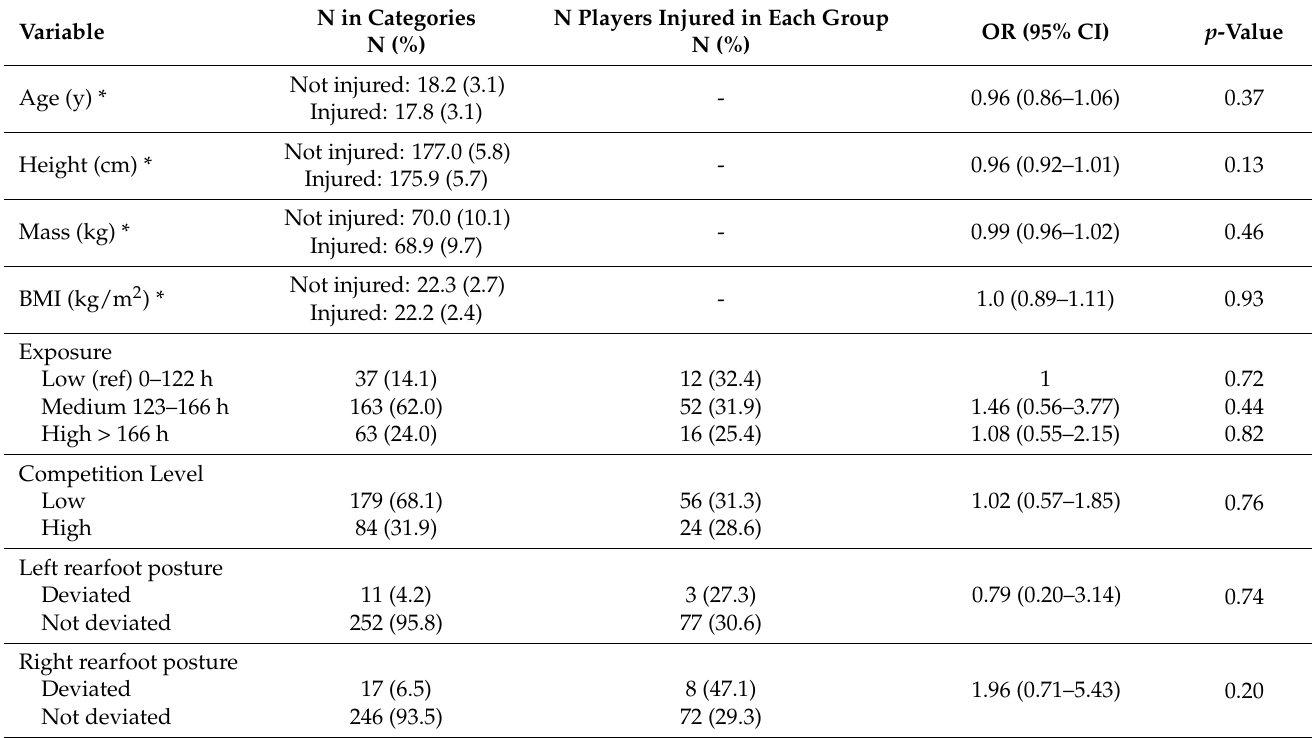
Table 4. Univariate regression analysis for factors potentially associated with previous injuries in football players ( n = 263), with descriptive statistics for each variable